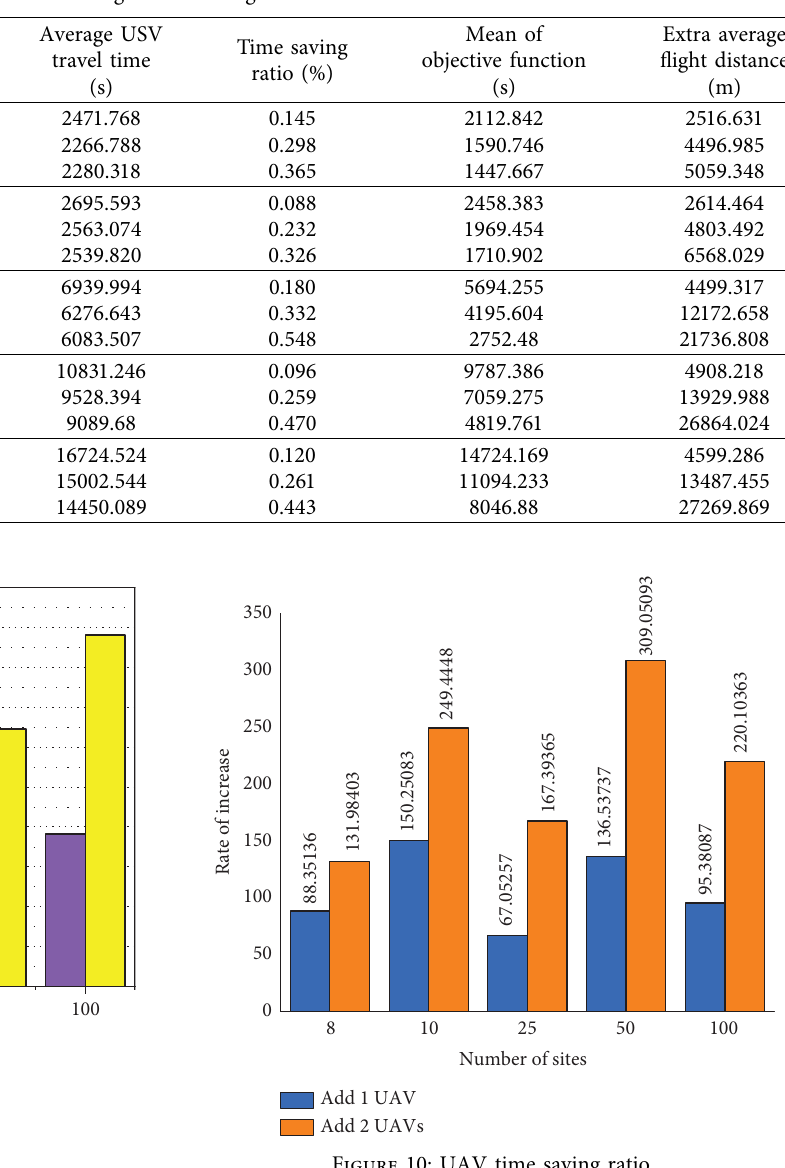
Table 4: Large scale solving statistics.